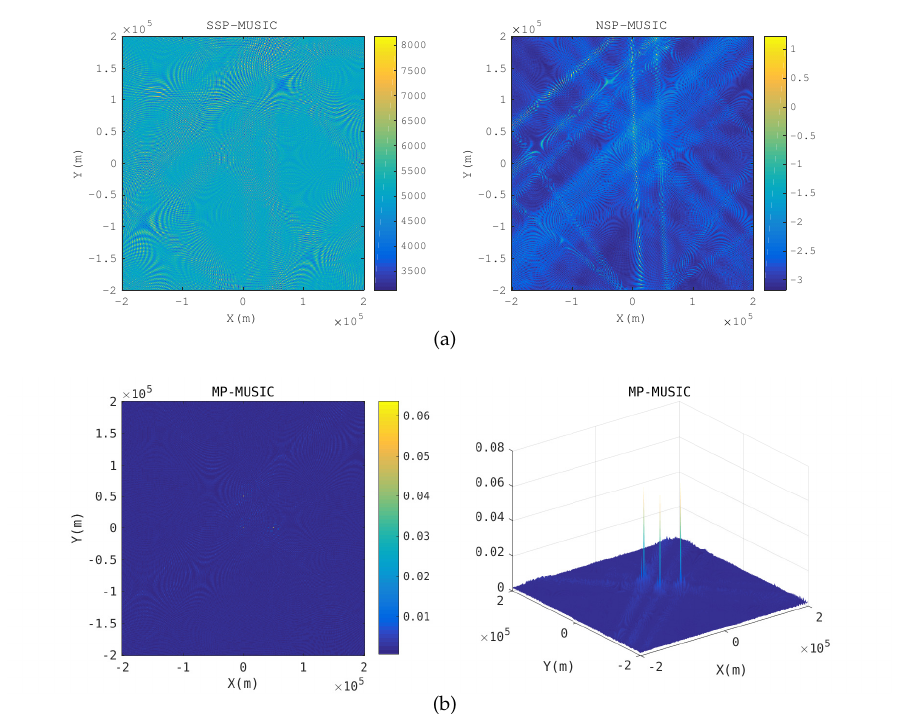
Figure 8. Spatial spectrum in a general scenario. ( a ) Spatial spectrum of SSP-MUSIC and NSP-MUSIC ( b ) Spatial spectrum of MP-MUSIC.